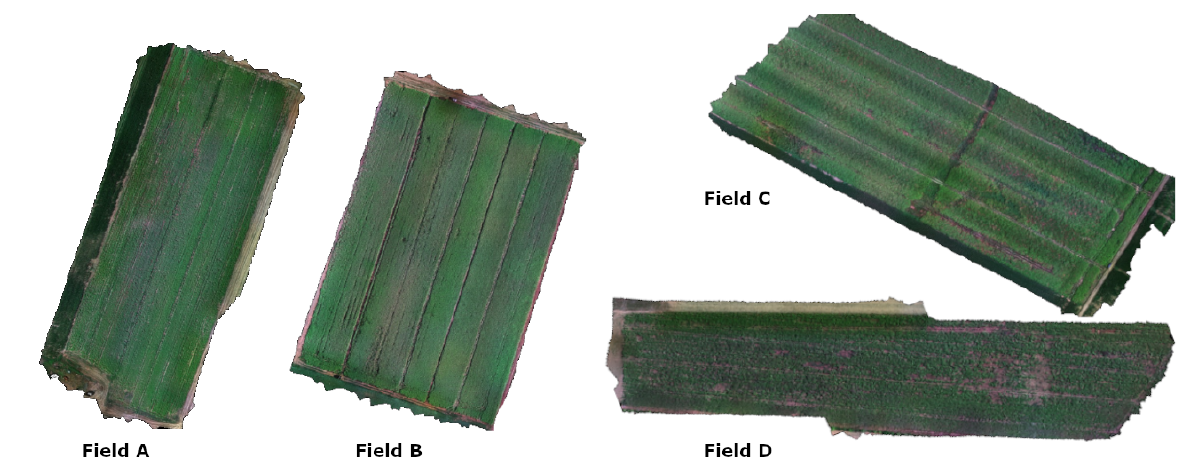
Figure 1. Orthorectified UAV images of curly leaf-type parsley Fields A and B and flat-type parsley Fields C and D acquired at a 40 m